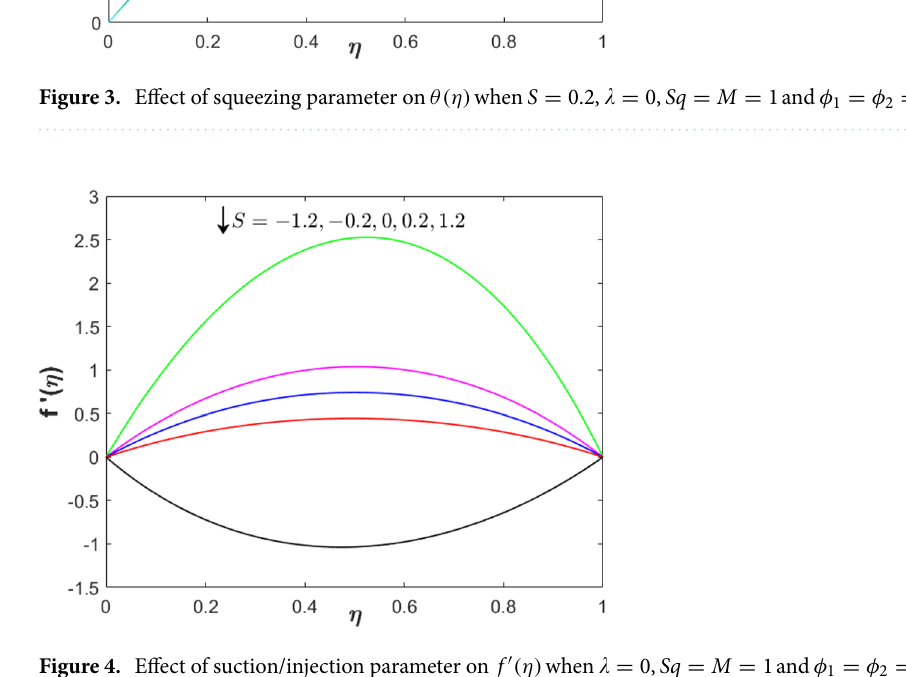
Figure 4. Effect of suction/injection parameter on f ′ (η) when (cid:31) = 0 , Sq = M = 1 and φ 1 = φ 2 = 0.01